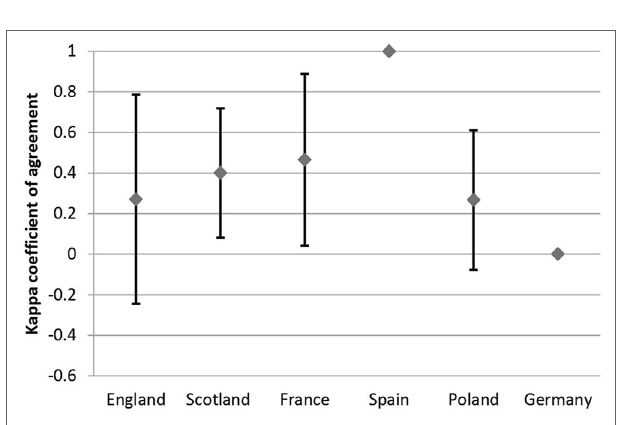
FIGURE 4 | Agreement Between Recommendations and Reimbursement Status—oncologic drugs.